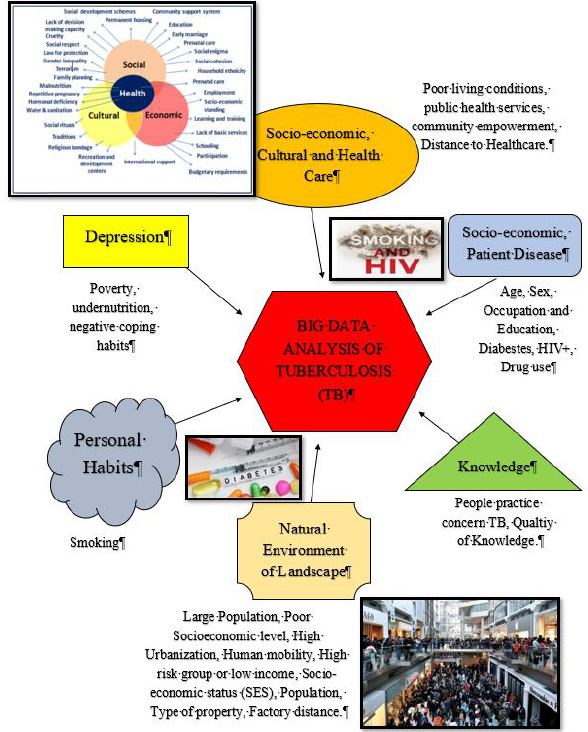
Figure 6 . Big data analysis of Tuberculosis